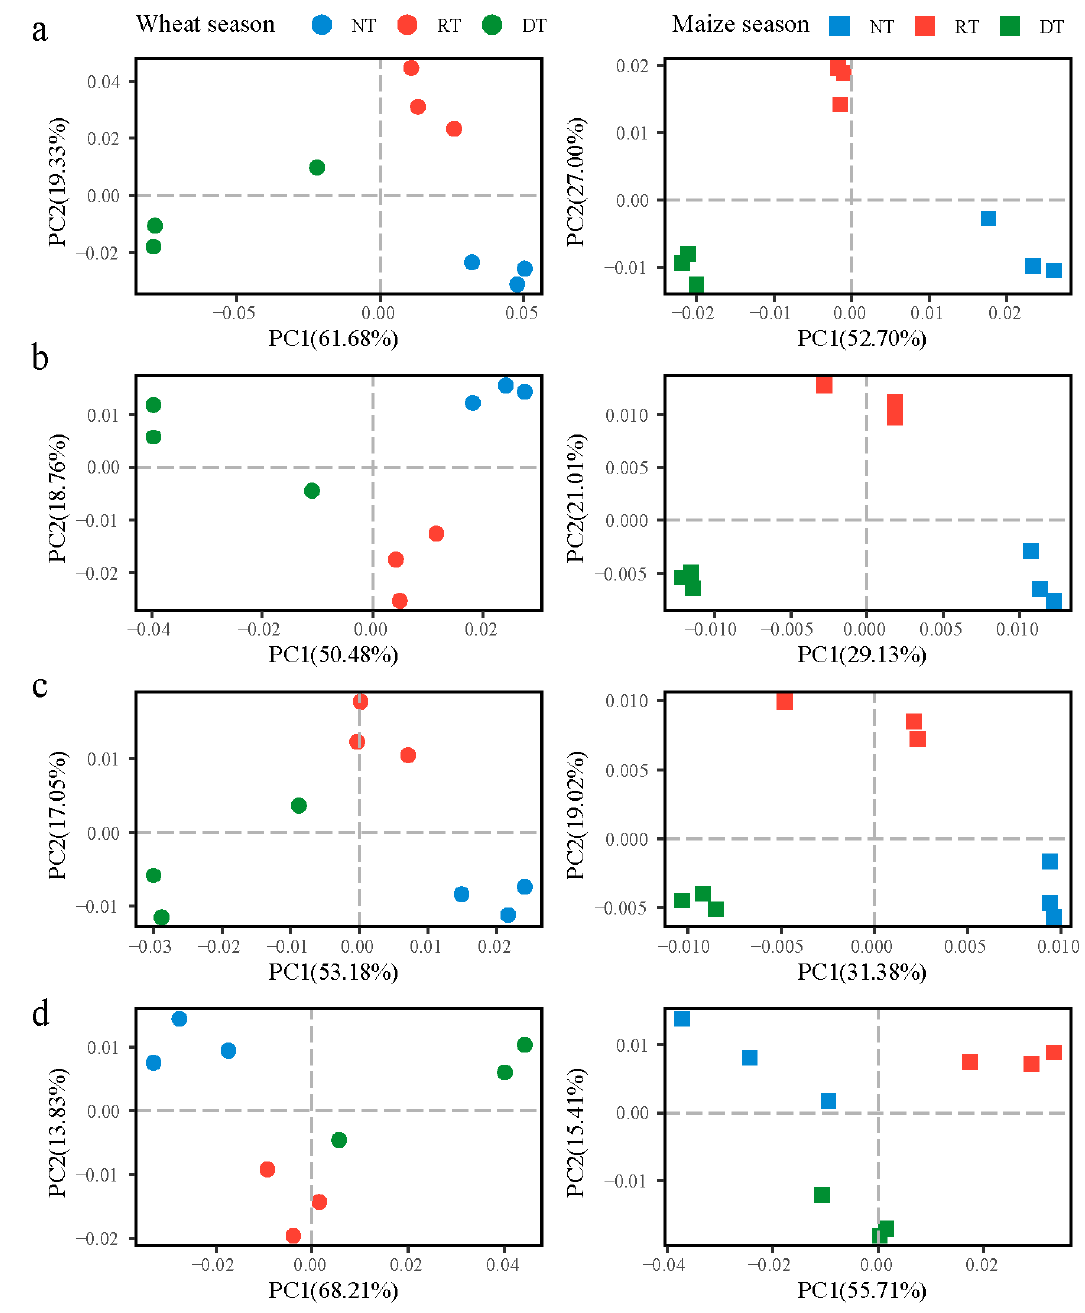
Figure 2. Principal co-ordinate analyses of variation among the ( a ) NR database; ( b ) eggNOG database; ( c ) KEGG database, and ( d ) CAZy database gene profiles based on Bray–Curtis distances. The relative abundance of dominant phyla in the 0–20 cm layer with no tillage (NT), rotary tillage (RT), and deep tillage (DT). The left charts represent the wheat season, and the right charts represent the maize season.